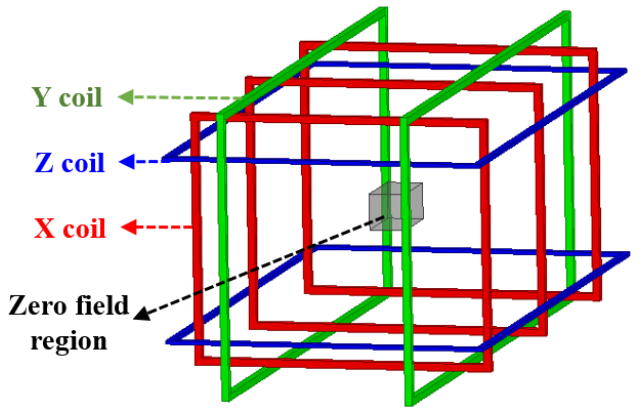
Figure 15. Laboratory environment in which external environmental influences were eliminated by 3-axis coils.